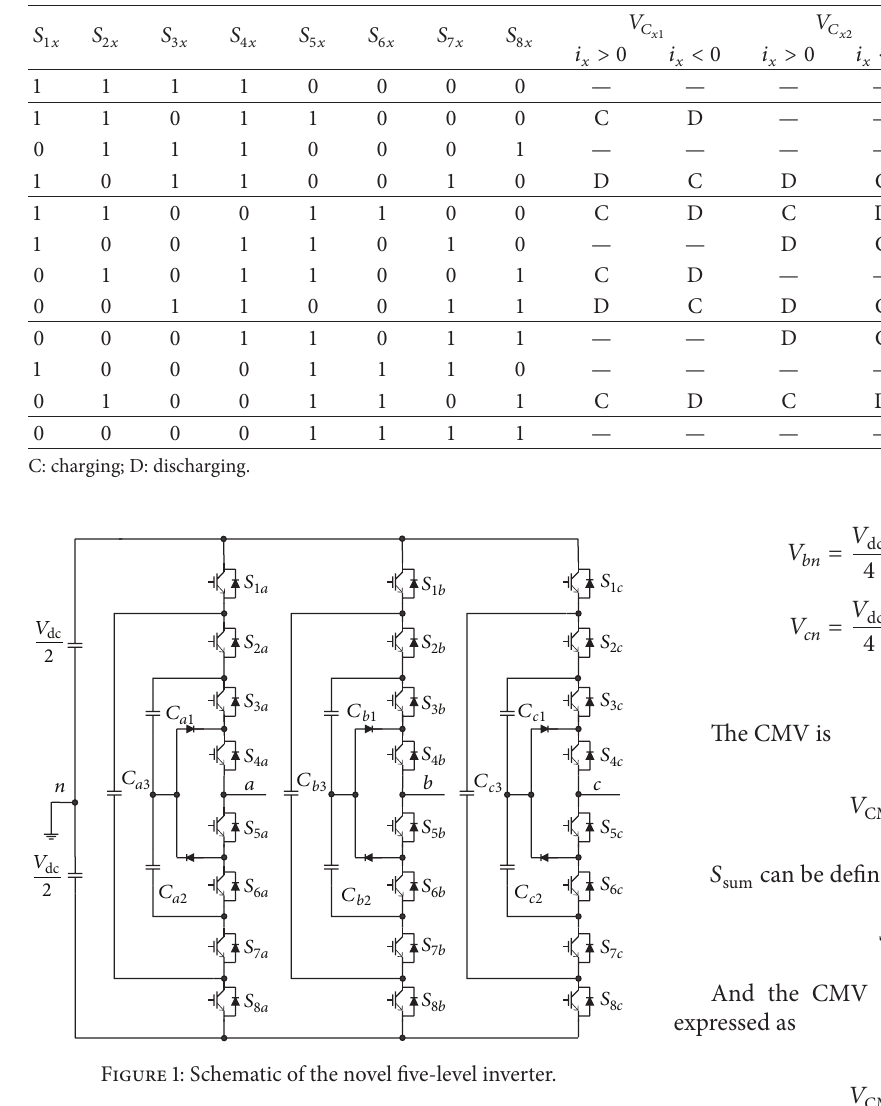
2.2. Common-Mode Voltage in the Novel Five-Level